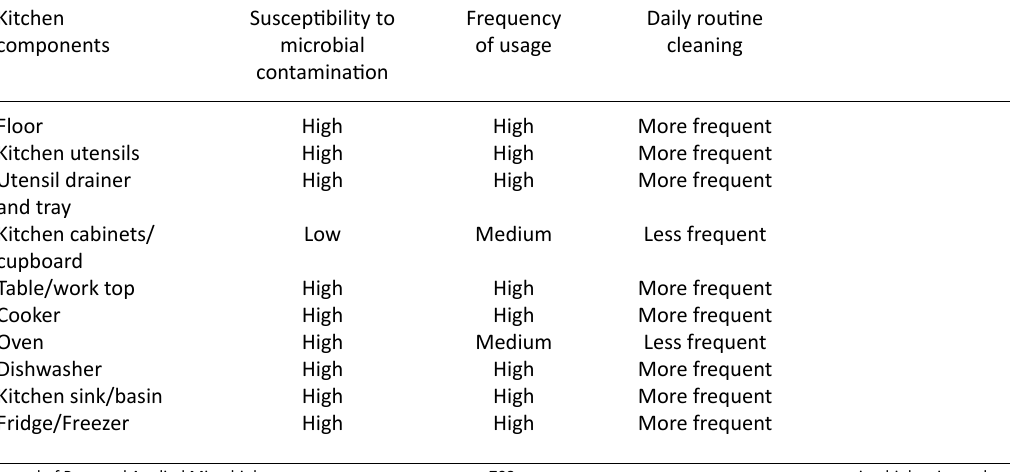
table 1. Hypothetical scenario of susceptibility to microbial contamination, frequency of usage and daily cleaning routine of various kitchen components Kitchen Susceptibility to